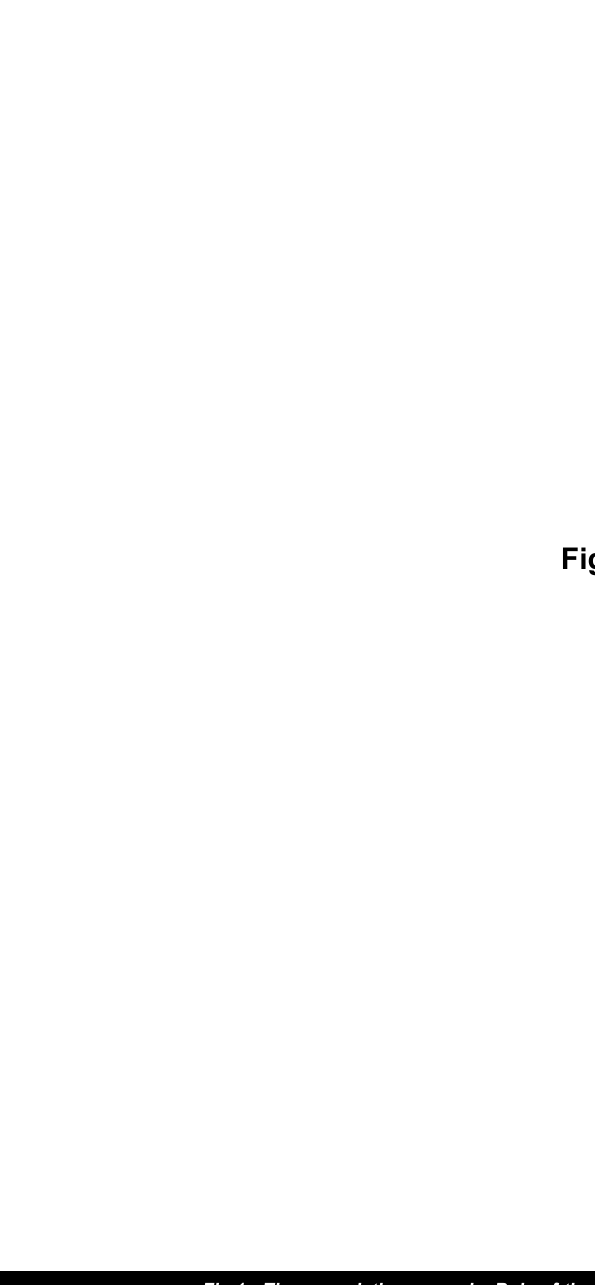
Fig.1 : The coagulation cascade, Role of the protein C in the process of blood coagulation.